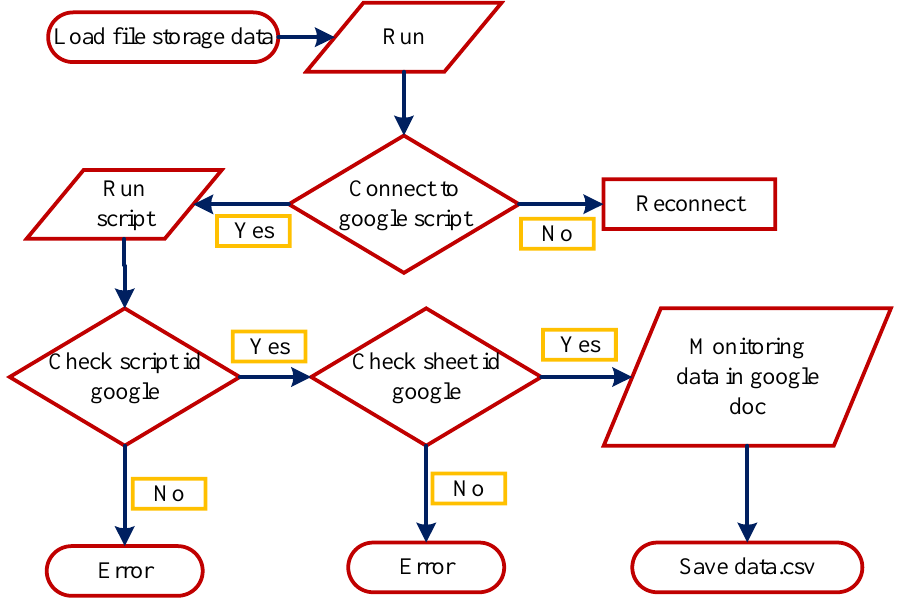
Figure 5. Data storage by cloud service flowchart.